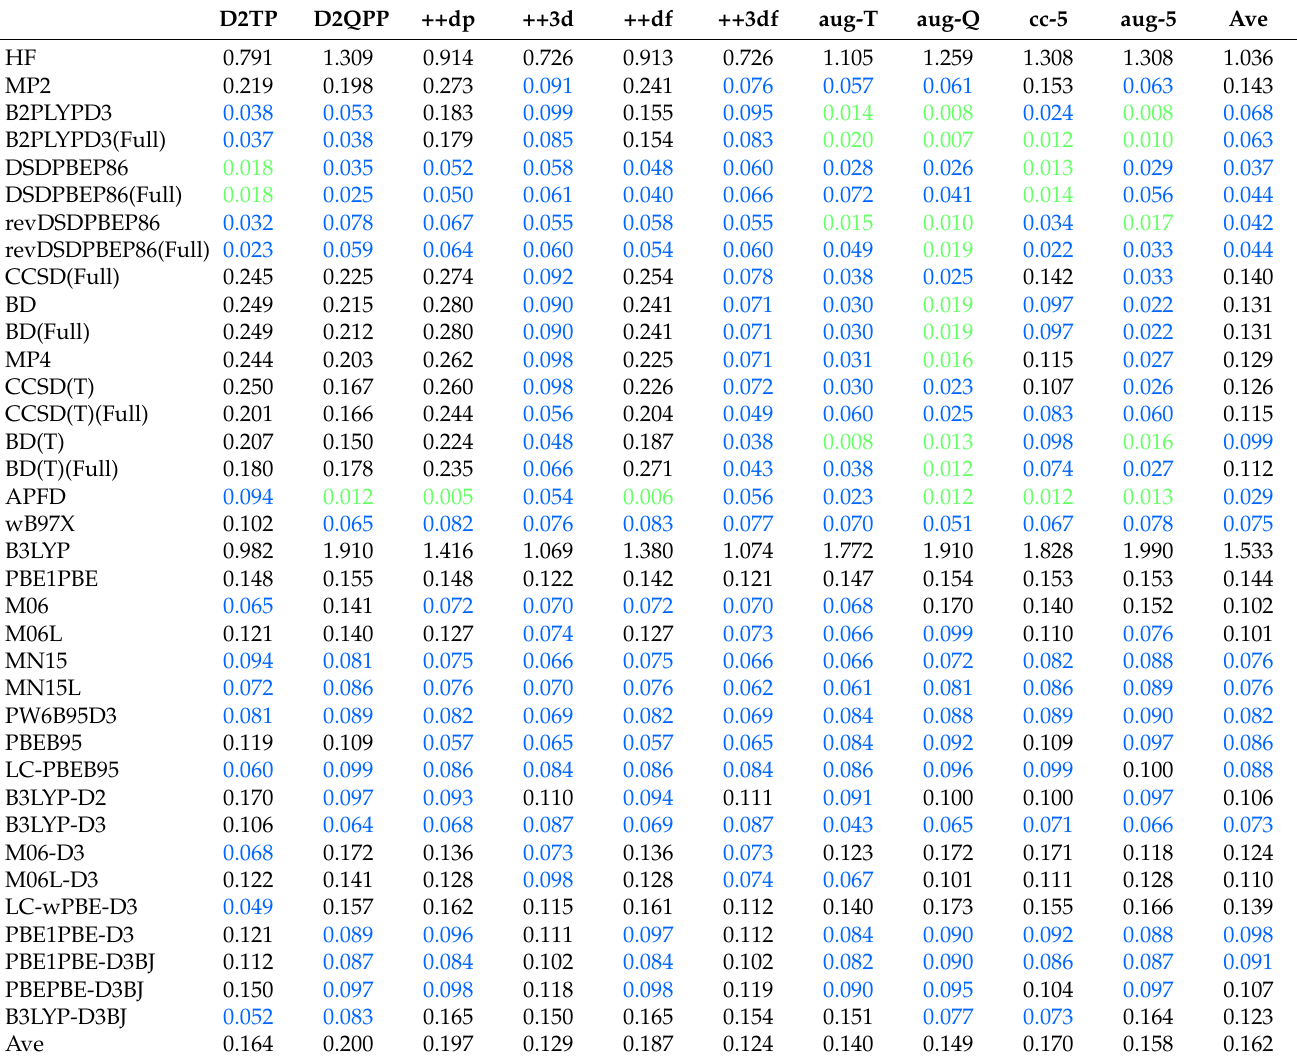
Table 1. MADs (Å) of some methods calculating the